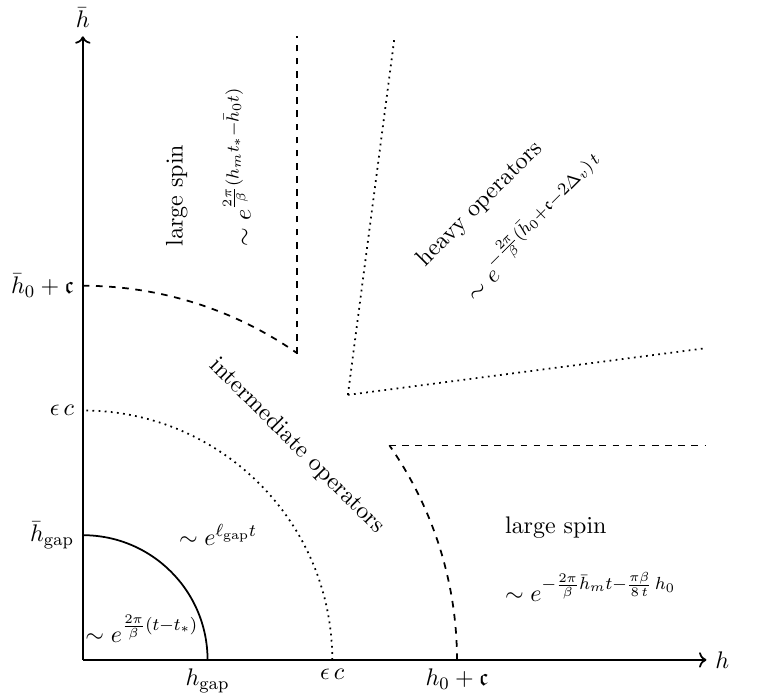
Figure 5 . A rough characterization of the results for the chaos correlator (temporal dependence alone) in various domains analyzed in the